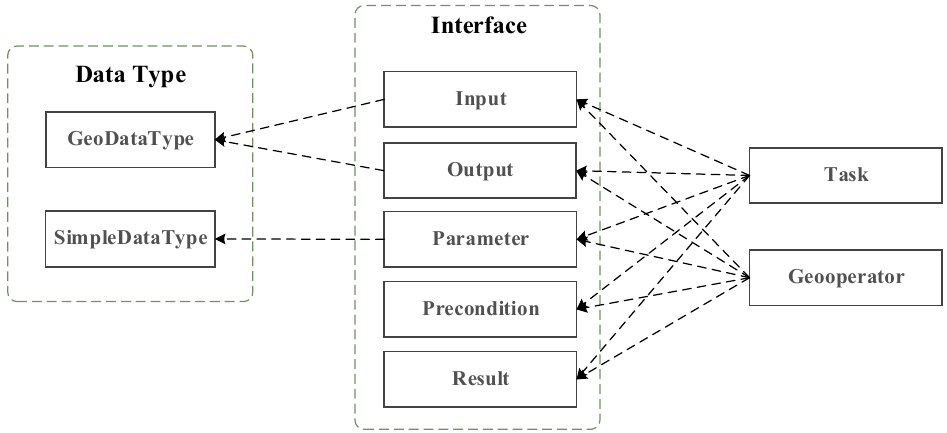
Figure 7. Interface for annotating Task and Geooperator, and Data Type for specifying